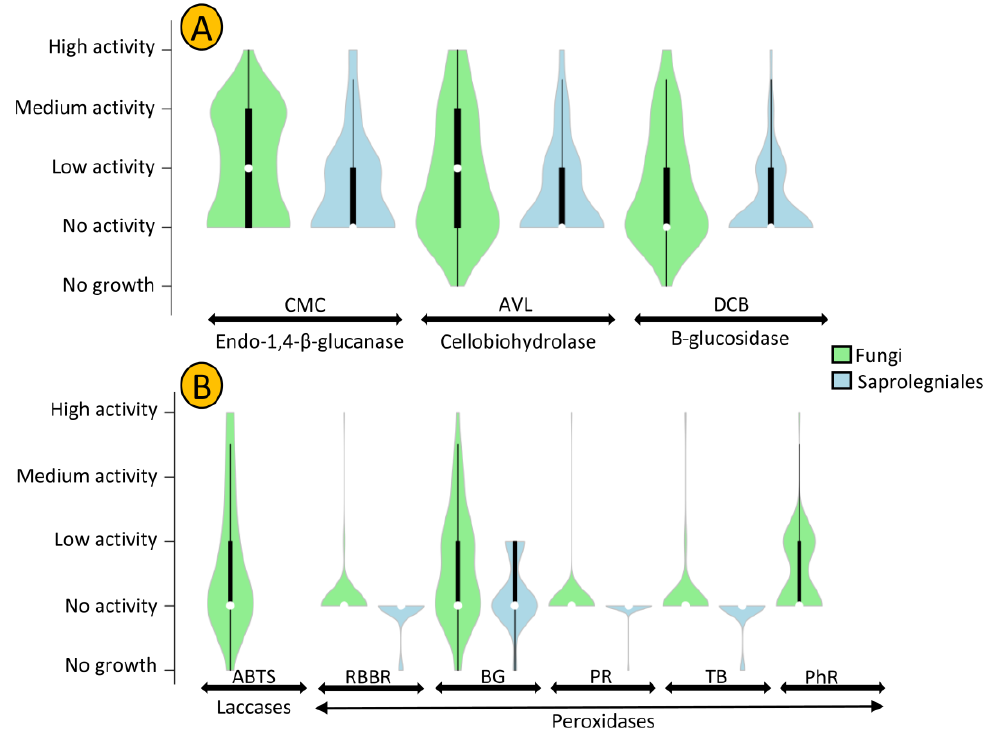
Figure 5. The levels of cellulolytic ( A ) and ligninolytic ( B ) activity of oomycete and fungal strains isolated in this study. CMC (carboxymethylcellulose), AVL (Avicel), and DCB (D-cellobiose) are substrates amended in cultures to detect the presence of enzymes involved in cellulolytic activity. ABTS, RBBR, BG, PR, TB, and PhR are substrates amended in cultures to assess the presence of enzymes involved in ligninolytic activity. White circles show the medians; box limits indicate the 25th and 75th percentiles as determined by R software; whiskers extend 1.5 times the interquartile range from the 25th and 75th percentiles; polygons represent density estimates of data and extend to extreme